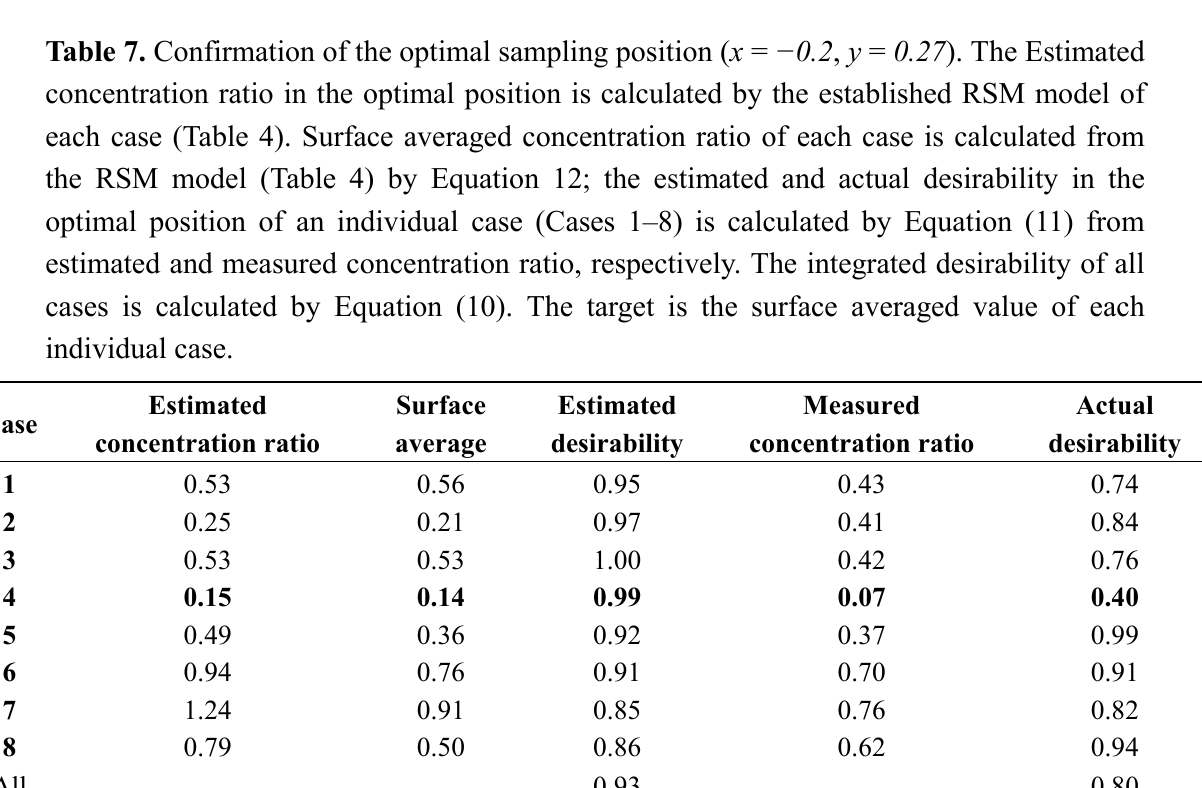
Table 7. Confirmation of the optimal sampling position ( x = − 0.2 , y = 0.27 ). The Estimated concentration ratio in the optimal position is calculated by the established RSM model